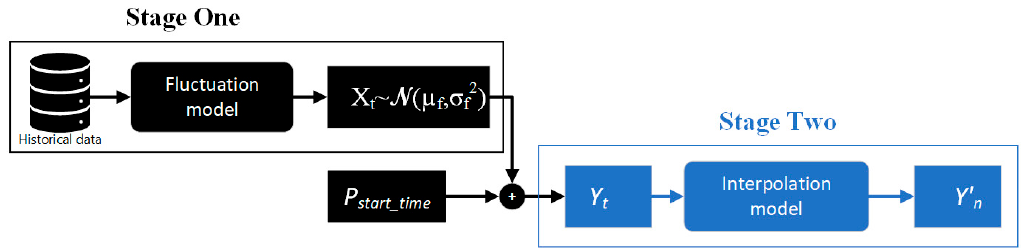
Figure 3. Predictive fluctuation model.